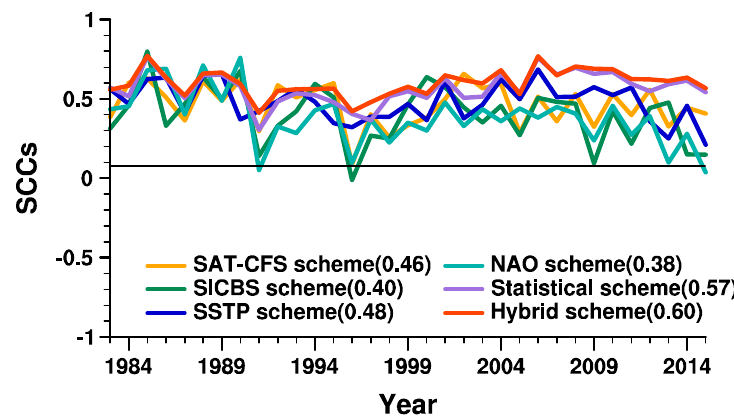
Figure 7. The temporal correlation coefficients (TCCs) between the spring (April–May–June (AMJ)) NDVI3g data and the cross-validation hindcast results of the ( a ) surface air temperature (SAT-CFS) scheme, ( b ) sea-ice cover (SIC) scheme, ( c ) sea surface temperature (SSTP) scheme, ( d ) North Atlantic Oscillation (NAO) scheme, ( e ) statistical scheme and ( f ) hybrid scheme during 1983–2015. Dotted regions are significant ( α = 0.05; t -test).